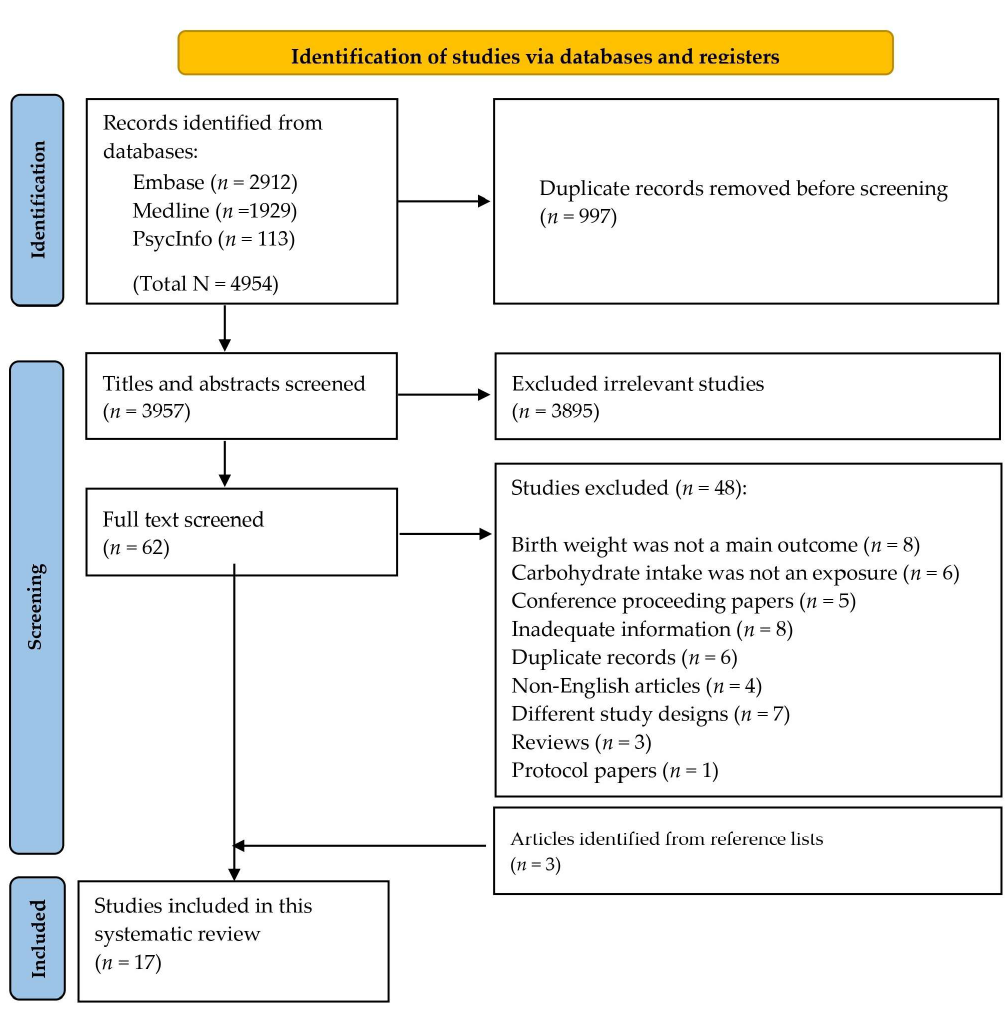
Figure 1. PRIMA flow chart for included studies